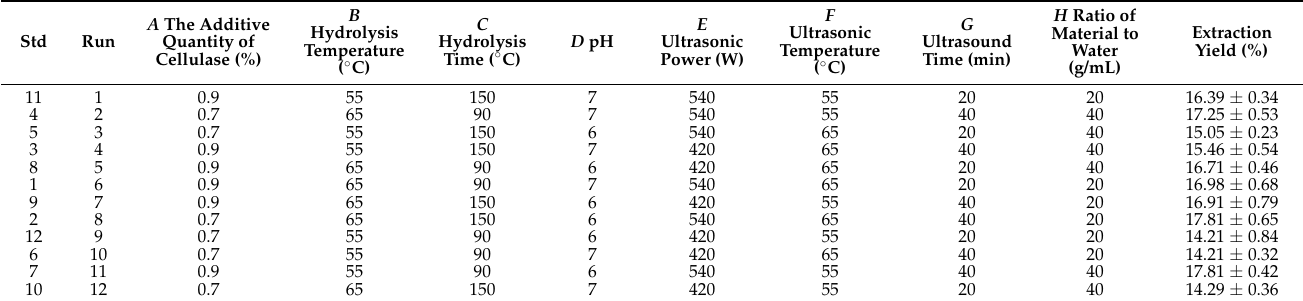
Table 1. Results of the Plackett–Burman test.